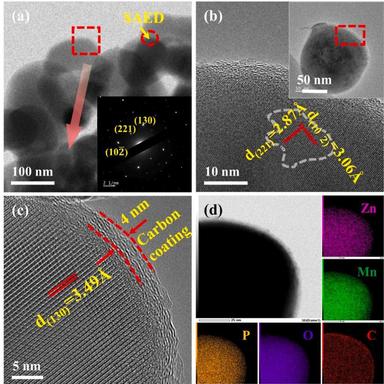
(a) Transmission electron microscopy (TEM) images of ZnMn2(PO4)2 @C. The inset is selected area electron diffraction (SAED) pattern; (b, c) High resolution transmission electron microscopy (HRTEM) images of ZnMn2(PO4)2 @C. The inset of b is TEM image of ZnMn2(PO4)2 @C particle. (d) Energy-dispersive spectrometry (EDS) mapping of ZnMn2(PO4)2 @C.